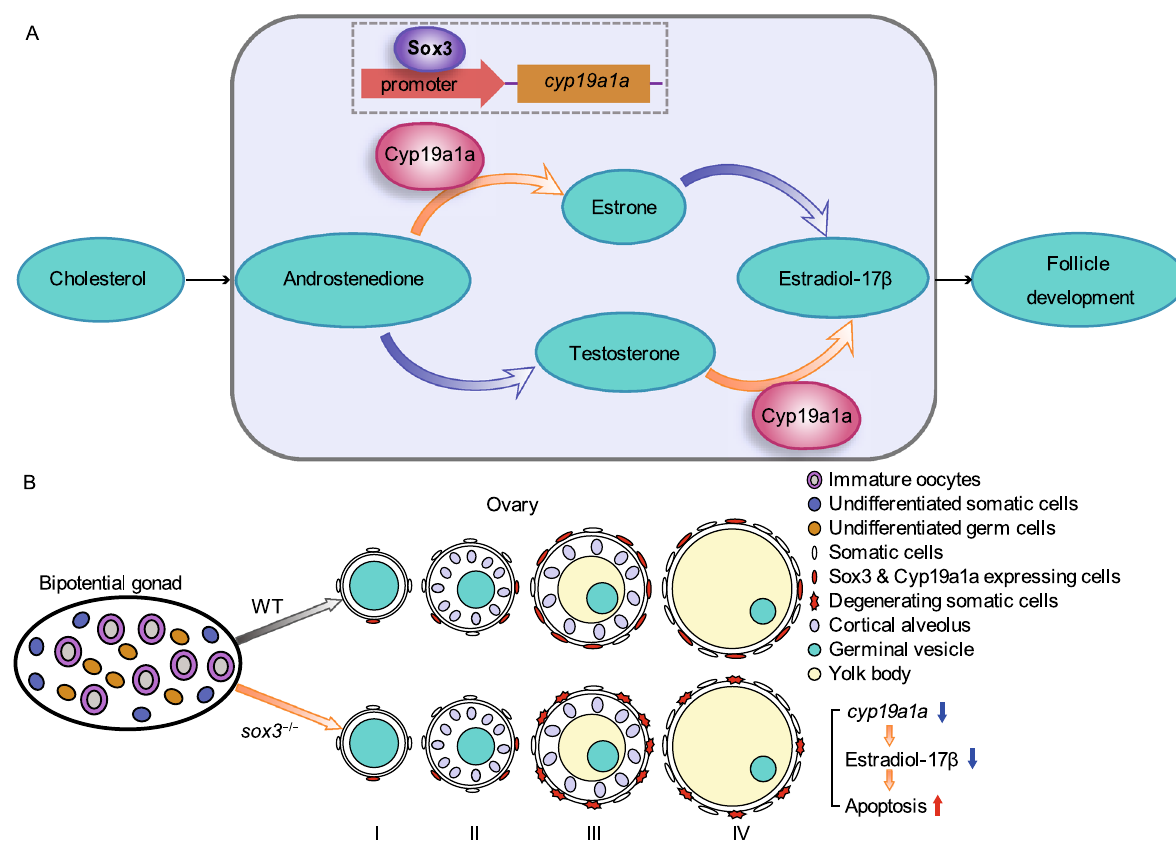
Figure 7. A work model for Sox3-Cyp19a1a in ovary development in zebra fi sh. (A) The pathway of 17 β -E2 synthesis in ovary. Sox3 binds to the promoter of cyp19a1a and up-regulates the cyp19a1a expression, which promotes 17 β -E2 synthesis via the two pathways, one is that androstenedione is converted to estrone and another is that testosterone is converted to 17 β -E2. (B) Wild-type juvenile gonads are bipotential between 22 – 28 dpf post fertilization. Cyp19a1a promotes ovary development by up-regulation of 17 β - E2 synthesis in wild type. In the absence of Sox3, the expression level of cyp19a1a is down-regulated, which results in a decrease of 17 β -E2, thus leads to somatic cell apoptosis in follicles, mostly at early-vitellogenic stage (III) and late-vitellogenic stage (IV), and a reduced